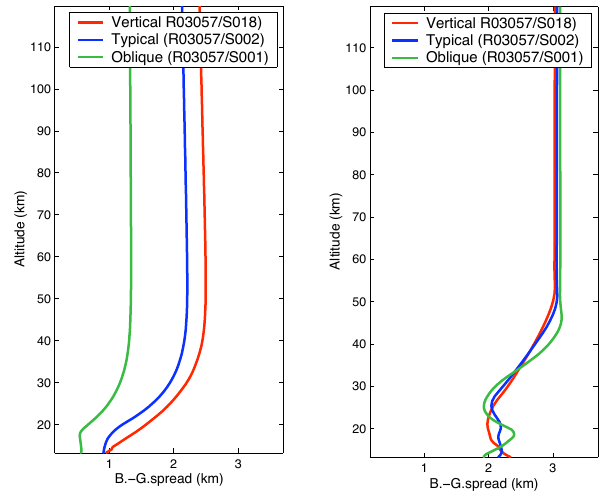
Fig. 10. Vertical resolution (Backus-Gilbert spread) of the ozone profiles in different occultation geometries as a function of altitude. On left: without regularizing, on right: with target resolution reg- ularization. Red line denotes vertical occultation, blue line typical occultation and green line oblique